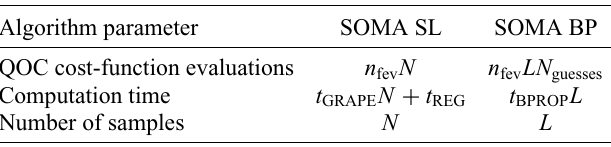
TABLE V. A comparison of SOMA SL and SOMA BP in terms of their performance features. Here, n fe v and t GRAPE are the max- imal number of function evaluations and the computation time required by L-BFGS-B with GRAPE to solve a single quantum control problem. t REG is the time required for the neural-network regression. t BPROP is the time required by the neural-network back propagation for one sample. Algorithm parameter SOMA SL SOMA BP QOC cost-function evaluations n fev N n fev LN guesses Computation time t GRAPE N + t REG t BPROP L Number of samples N